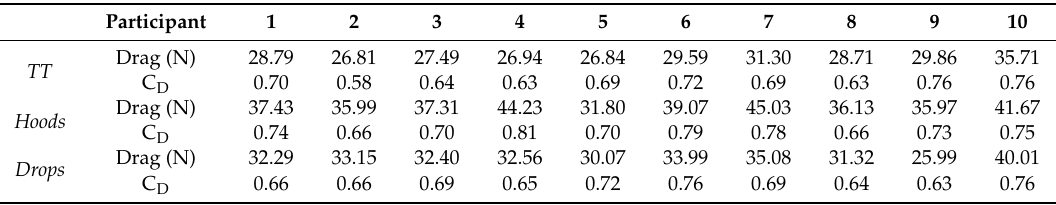
Table 3. Drag force of the 3D models from the Static protocol. C D was obtained by using Equation (1) and the area from the projected frontal area